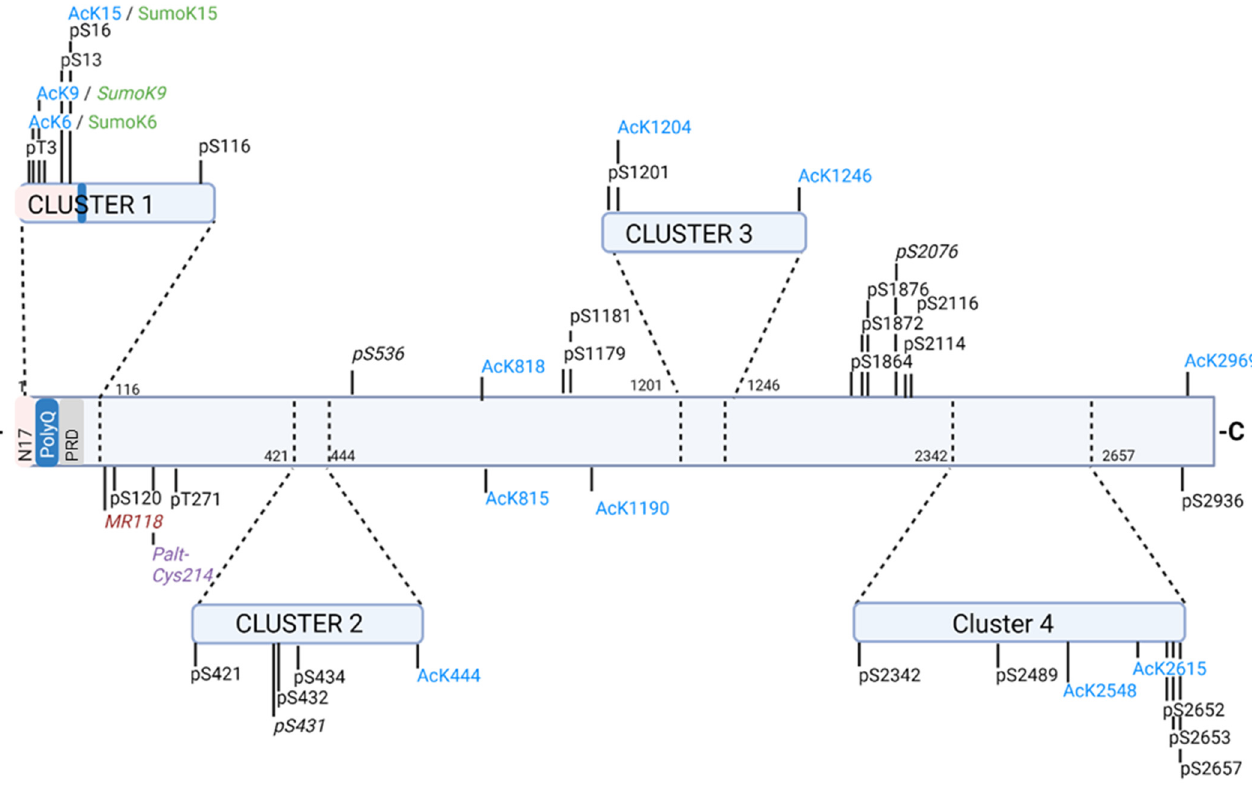
Figure 1. Post-translational modifications of HTT. Arbez et al. 2017 [72], identified clusters of phos- phorylations and acetylations that clustered around protease sensitive domains. These clusters were defined by a scoring system defined in Arbez et al. 2017 for the PTMs examined based on functional effects of mtHTT toxicity. In addition to those identified phosphorylations and acetylations seen to cluster in Arbez et al. 2017, other identified PTMs that have been shown to have an effect on HD/HTT toxicity in some capacities are included, more details on the effects for phosphorylations can be found in Table 2 (those italicized indicate PTMs not originally analyzed to belong to the clusters by Arbez et al. 2017). PTMs within the clusters can have summarized/generalized effects as follows (direction of these effects, whether beneficial or detrimental depends on the specific PTM); Cluster 1: Includes the N17 and PolyQ regions, along with exon 1. PTMs here largely affect nuclear localization, mtHTT aggregation, and mtHTT toxicity. Cluster 2 : Located between N terminal do- mains I and II. PTMs here largely show effects on mtHTT aggregation and toxicity, mitochondrial phenotype, and caspase cleavage. Cluster 3: Located between N-terminal domain II and C-terminal domain I. The one phosphorylation in this cluster, S1201 has been shown to protect against polyQ induced p53 mediated cell death, the acetylations may modulate mtHTT toxicity and mitochondrial potential changes. Cluster 4: Located in C-terminus domain II. PTMs here effect mitochondrial po- tential and can modulate mtHTT toxicity [72] . (Abbreviations and color code p (Black) = phosphor- ylation, Ac (Blue) = Acetylation, Palt (Purple) = palmitoylation, M (Red) = Methylation). Created with Biorender.com (accessed: 29 June 2022).